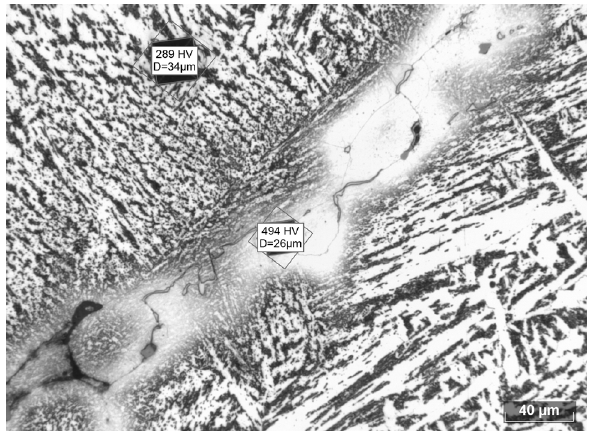
Figure 7. Nitrides at distances of 15 ( a ), 50 ( b ) and 90 ( c ) mm in CCB.